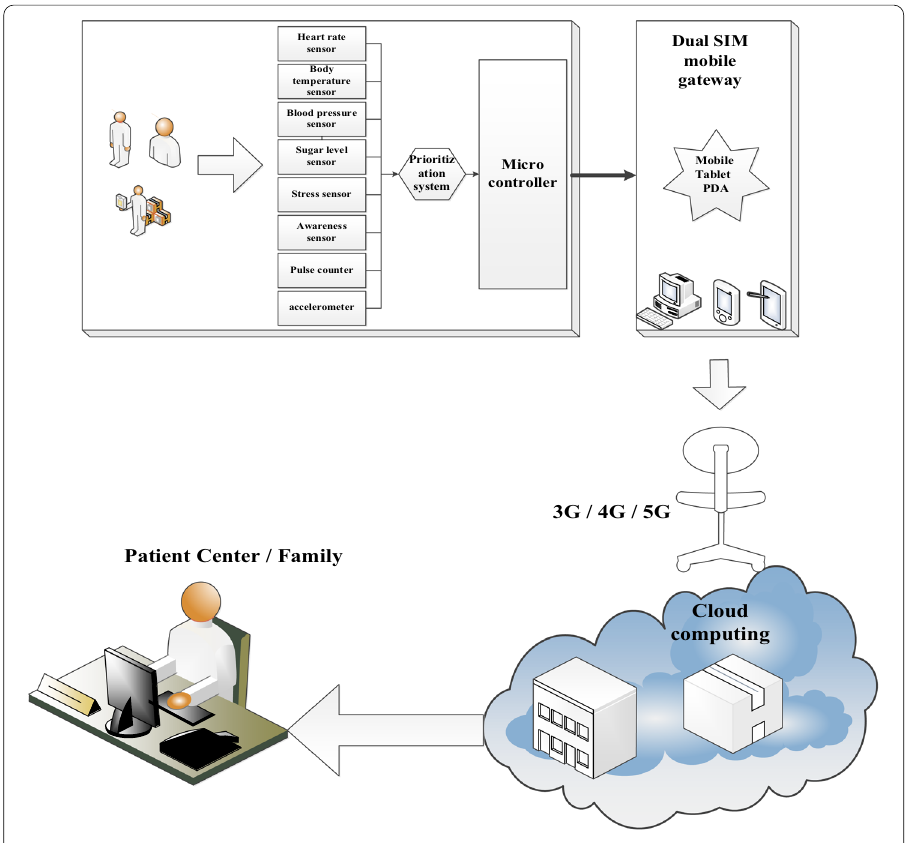
Fig. 1 The architecture of the proposed